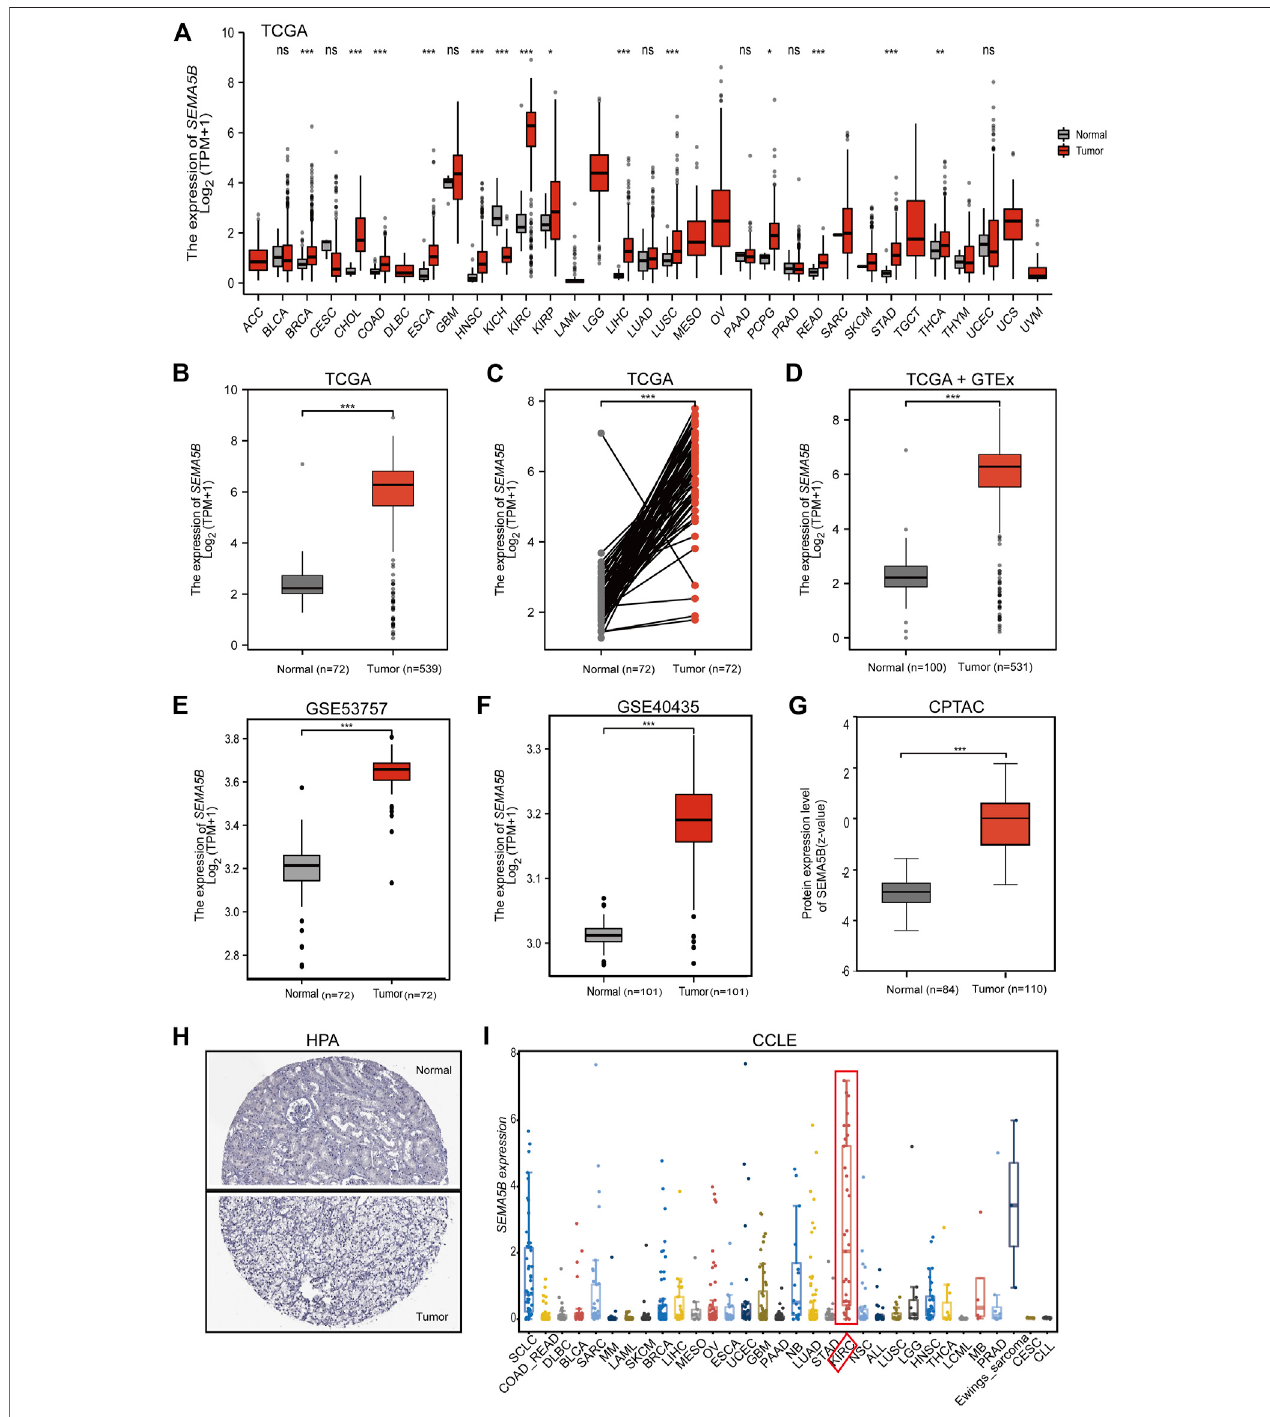
FIGURE 1 | The mRNA and protein level of SEMA5B in the KIRC tissue and KIRC cell lines. (A) The comparison of SEMA5B expression between tumor and noncancerous adjacent tissues in different types of cancers based on the TCGA database. (B) The expression of SEMA5B in normal and tumor tissues based on the TCGA. (C) The expression of SEMA5B in paired tissues based on the TCGA. (D) The expression of SEMA5B in normal and tumor tissues based on matching TCGA normal and GTEx data. The expression of SEMA5B in KIRC based on GSE53757 (E) and GSE40435 (F) . (G) Protein expression levels of SEMA5B in normal and KIRC tumor tissues based on the CPTAC dataset. (H) Representative immunohistochemistry images of SEMA5B in KIRC and normal tissues derived from the HPA database. (I) The mRNA expression levels of SEMA5B in kidney cancer cell lines using the CCLE. ns, p ≥ 0.05; * p < 0.05; ** p < 0.01; *** p < 0.001.